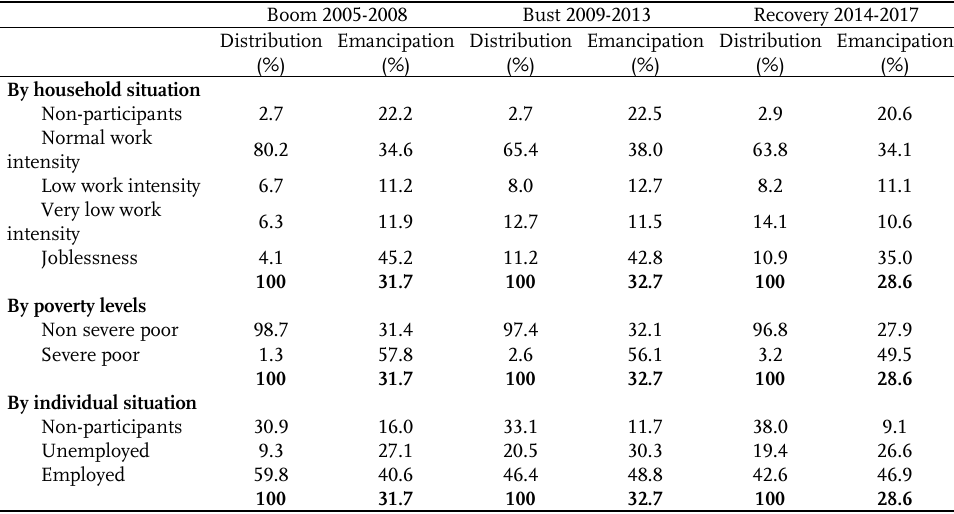
Table 1: Emancipation rates and distribution of the young population aged 16-34 by household precariousness levels and individual labour market status in boom, bust and recovery periods, 2005-2017 Boom 2005-2008 Bust 2009-2013 Recovery 2014-2017 Distribution Emancipation Distribution Emancipation Distribution Emancipation (%) (%) (%) (%) (%)